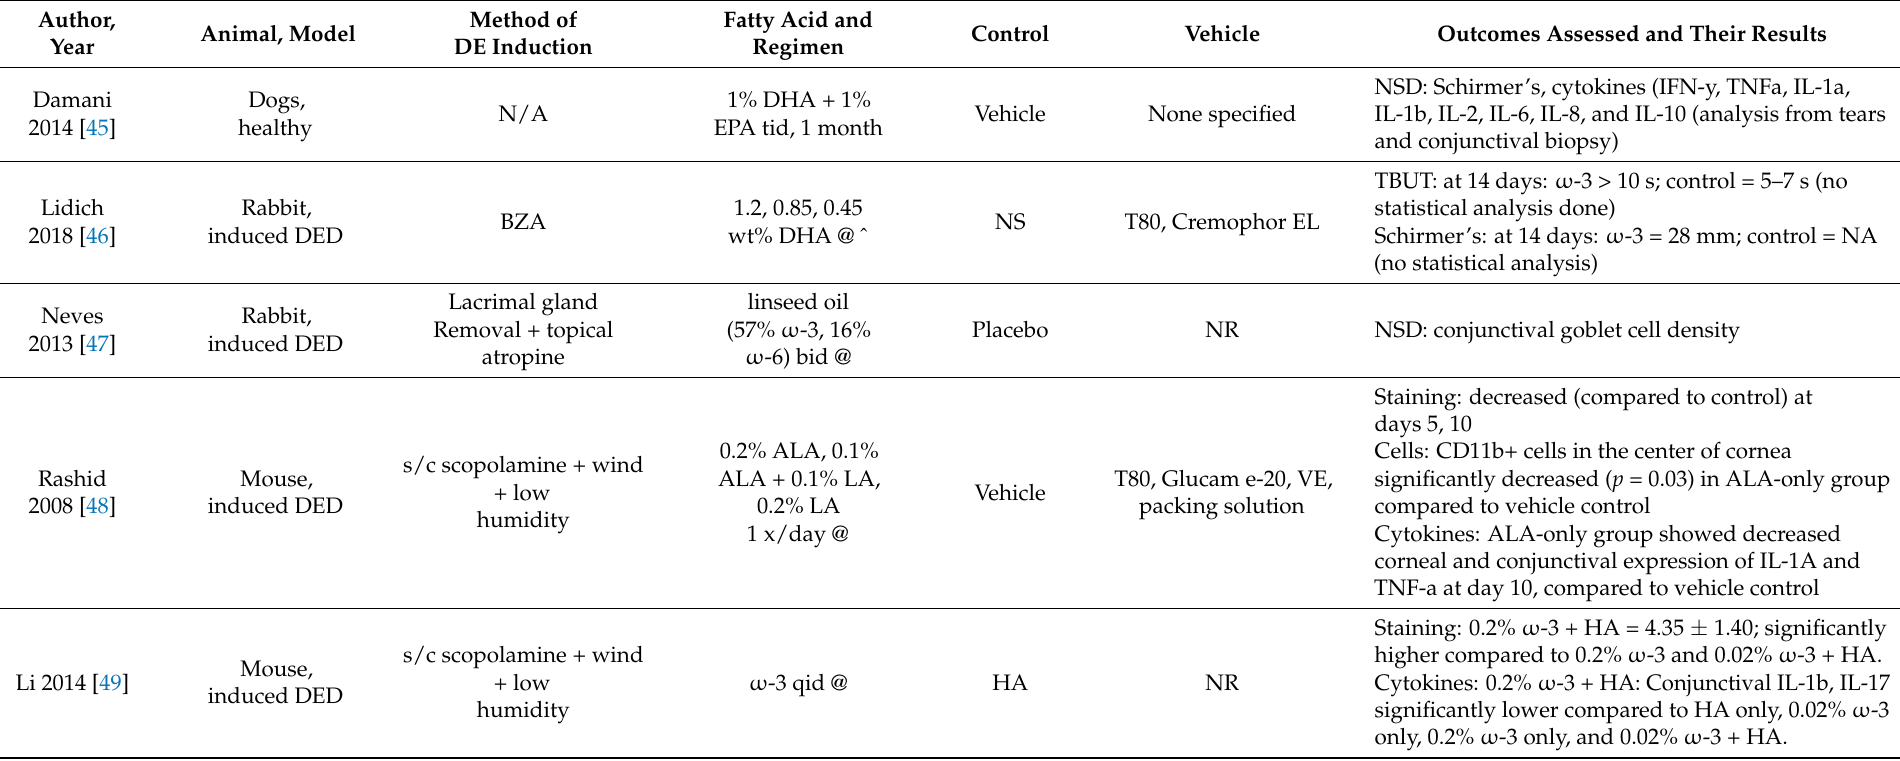
Table 5. Animal studies and